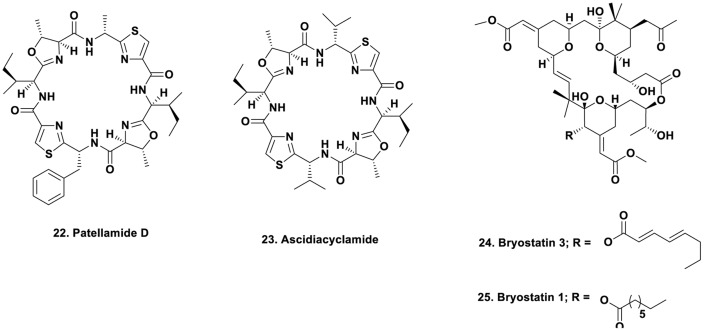
Compounds 22 to 25.